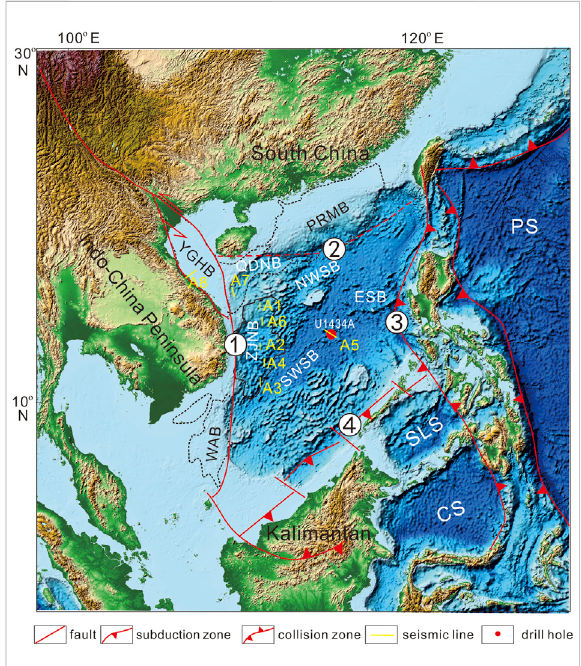
FIGURE 1 Regional tectonic background of the Zhongjiannan Basin, SouthChinaSeaYGHB-YinggehaiBasin,PRMB-PearlRiverMouth Basin, QDNB- Qiongdongnan Basin, ZJNB- Zhongjiannan Basin, WAB- Wan ‘ an Basin, NWSB- northwest subbasin of SCS, SWSB- Southwest Subbasin of SCS, ESB- East Subbasin of SCS, SLS- Sulu Sea, CS- Celebes Sea, PS- Philippine Sea: (1)- Combined belt of Western SCS, including RRF in the north, WEFSCS in center and Wan ‘ an Fault in the south, (2)- Combined belt of Northern SCS, namely, Qiongnan suture zone, (3)- subduction-collision zone of Eastern SCS, (4)- Subduction collision zone of